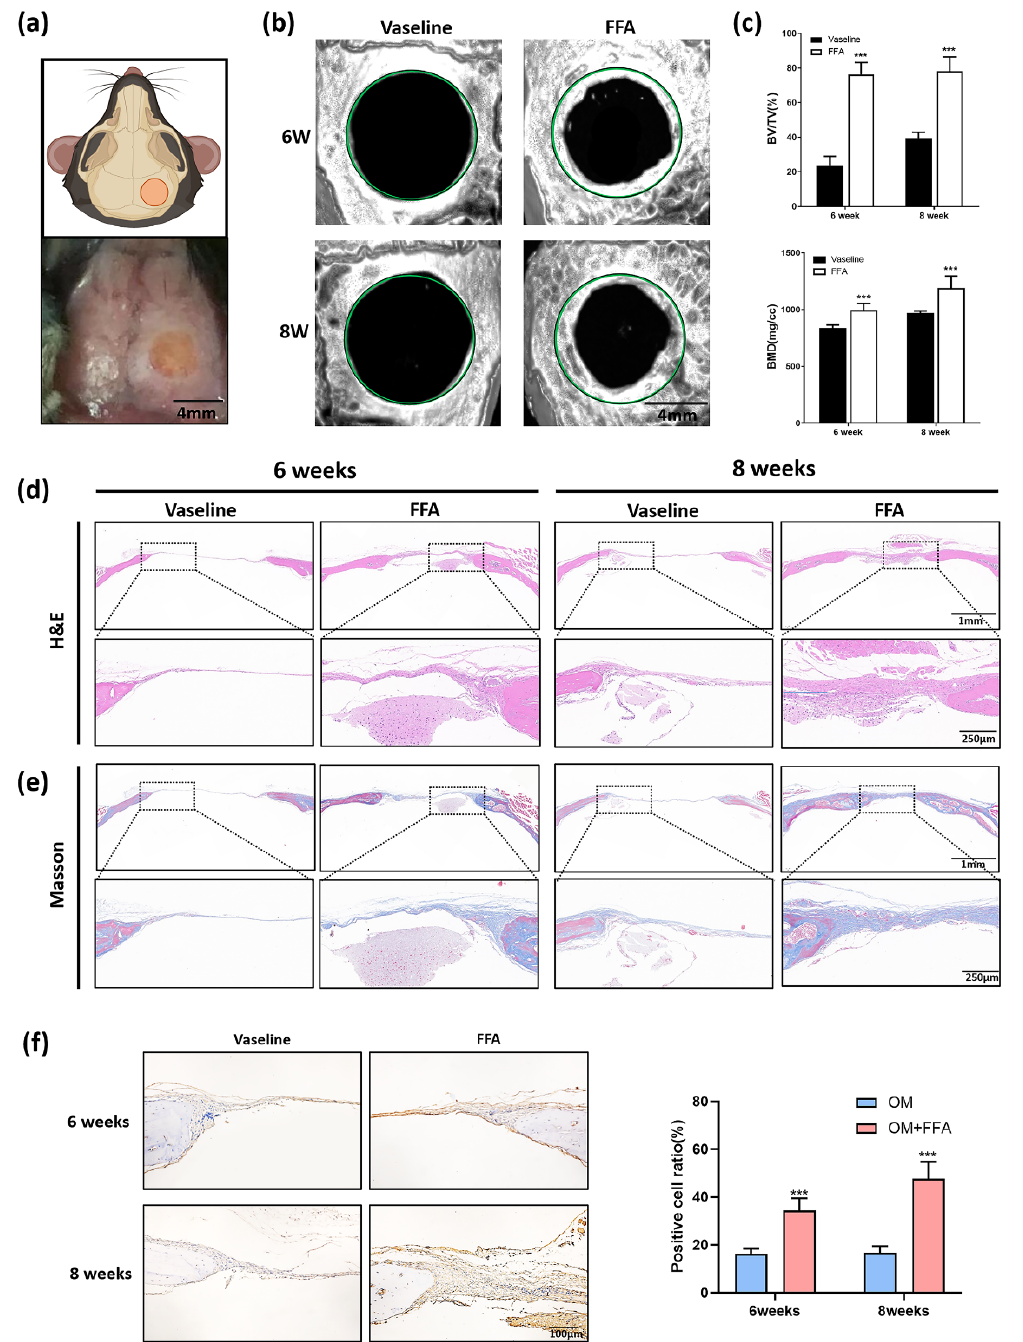
Figure 1. Application of butyl flufenamate ointment to the skin surface promoted cranial-defect healing in mice. ( a ) Schematic diagram and clinical operation picture of mice cranial defects. Scale bar = 4 mm. ( b ) Micro CT 3D reconstruction images of cranial defects showing that butyl flufenamate ointment promoted new bone formation after 6 weeks. Treatment with butyl flufenamate ointment had a stronger effect after 8 weeks than after 6 weeks. Scale bar = 2 mm. ( c ) Improvements in BV/TV and BMD in the defect areas after butyl flufenamate compared with Vaseline treatment, especially after 8 weeks. ( d , e ) Hematoxylin–eosin and Masson’s trichrome staining images of the cranial-defect area in each group. Scale bar = 1 mm and 250 μm. ( f ) IHC staining (OCN) of the cranial-defect area in different groups. Scale bar = 100 μ m. *** p < 0.001.